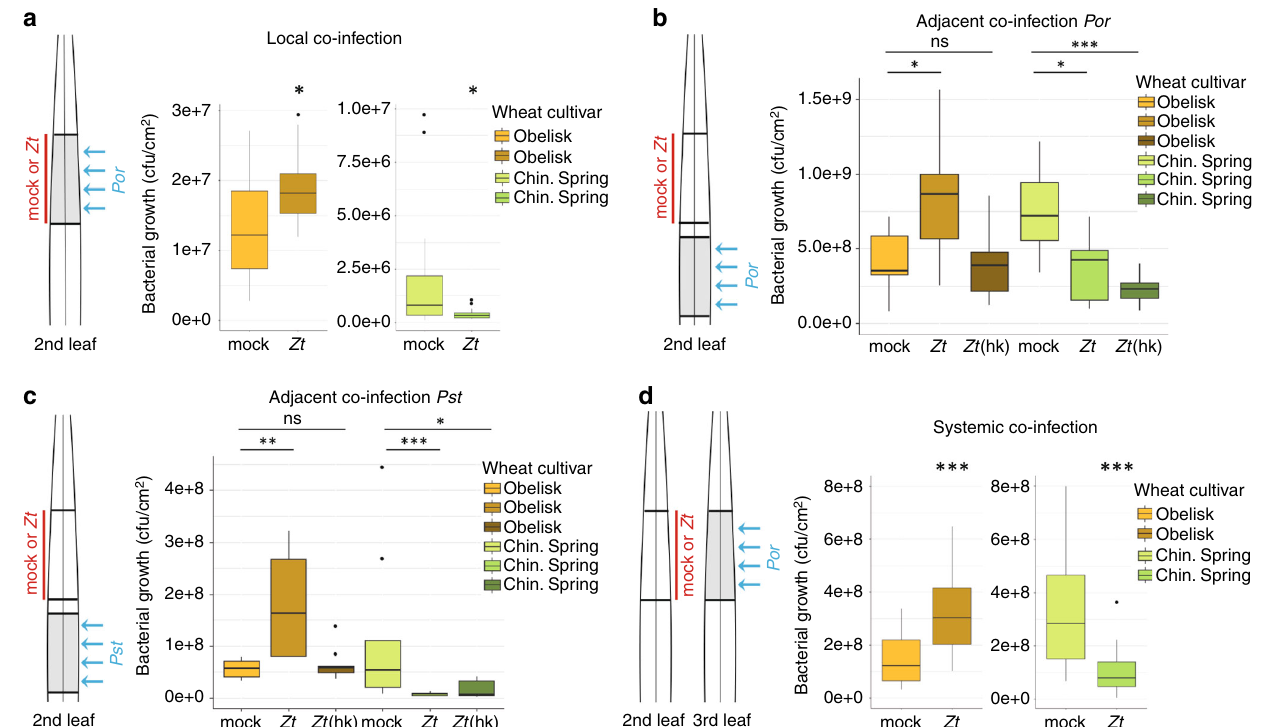
Fig. 2 Infection of wheat with Z. tritici changes resistance to bacterial pathogens in local and systemic leaf tissues. a Local coinfection (schematic) of wheat cultivar Obelisk (orange/brown) and cultivar Chinese Spring (green) with Z. tritici ( Zt ) IPO323 (red) on second leaf followed by P. syringae pv. oryzae ( Por ) (blue) on the same area of the leaf at 4 dpi-f and quanti fi cation of bacterial growth after an additional 4 days. b , c Adjacent coinfection (schematic) with Zt or heat-killed (hk) Zt locally (red) followed by Por ( b ) or P. syringae pv. tomato (Pst) ( c ) (blue) on an adjacent leaf area at 4 dpi-f and quanti fi cation of bacterial growth after an additional 4 days. d Systemic coinfection (schematic) of wheat cultivar Obelisk (orange/brown) and cultivar Chinese Spring (green) with Zt IPO323 (red) on the second leaf followed by P. syringae pv. oryzae ( Por ) (blue) at 4 dpi-f and quanti fi cation of bacterial growth after an additional 4 days. Bacterial coinfection took place on the third leaf. Statistical analysis was performed using the Shapiro – Wilk test of normality, which was then followed by the Wilcoxon rank-sum test for test of null hypothesis. * P < .05; ** P < .01; *** P < .001; ns not signi fi cant. Number of